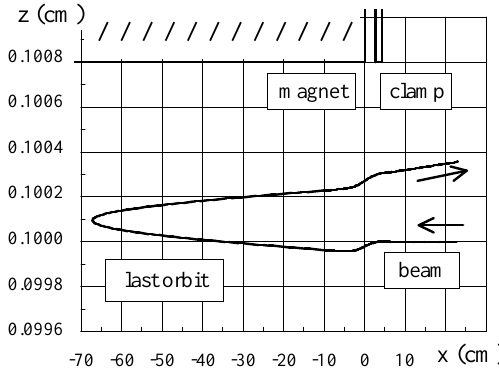
FIG. 6. Last orbit trajectory of a particle coming into the reverse fringe field 0.1 cm above the middle plane.